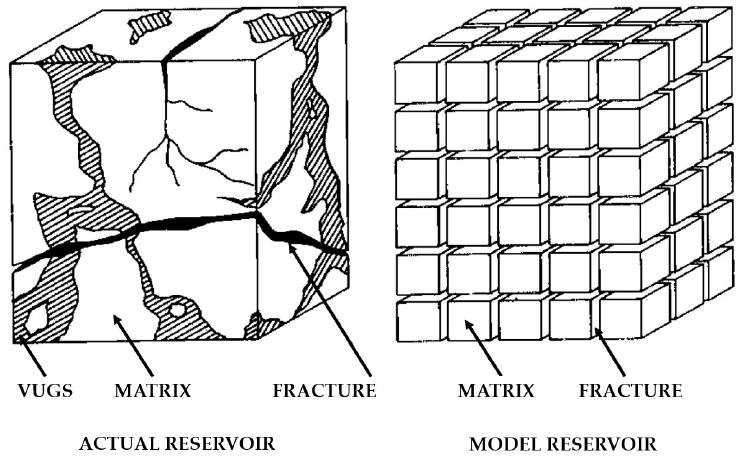
Figure 2. Schematic illustration of dual porosity model [21]. Reproduced from [21], Warren: 1963.